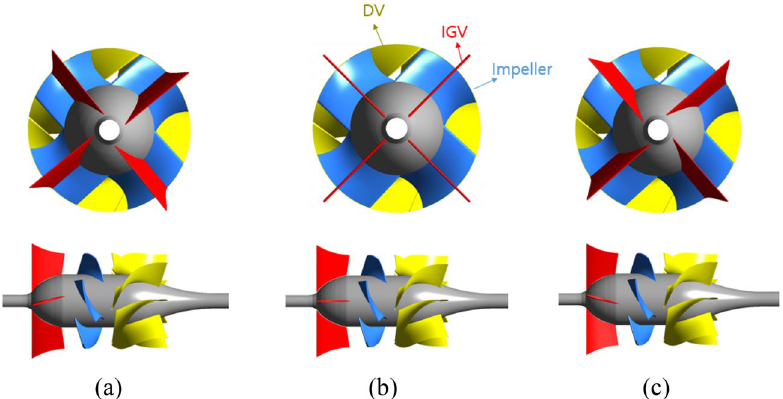
Figure 5. Front view and side view of axial-flow pump. ( a ) Negative IGV’s setting angle, ( b ) reference model, and ( c ) positive IGV’s setting